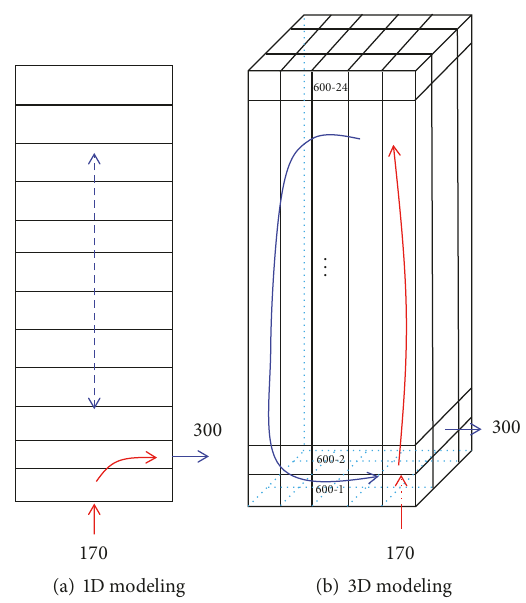
Figure 5: The flow behaviors in the cooling water